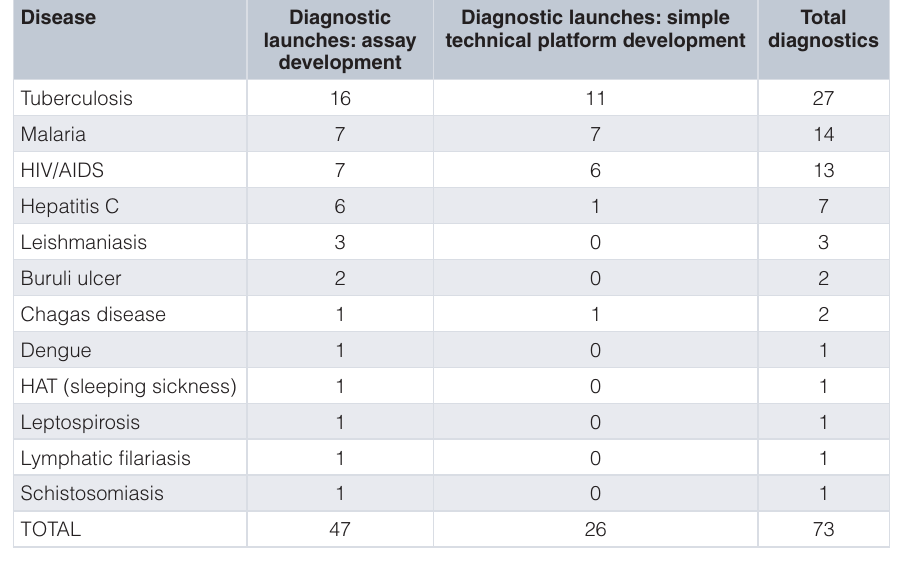
Table 9. Sensitivity analysis varying effect of changes in probability of success and cost of development per